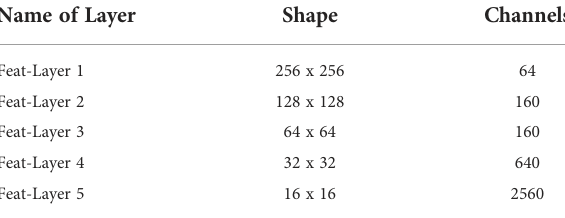
TABLE 1 The scale of different effective feature layers of the backbone.